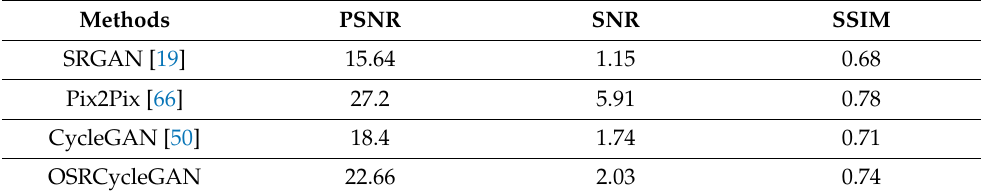
Table 5. Comparisons on SRR by the proposed method and state-of-the-art methods.